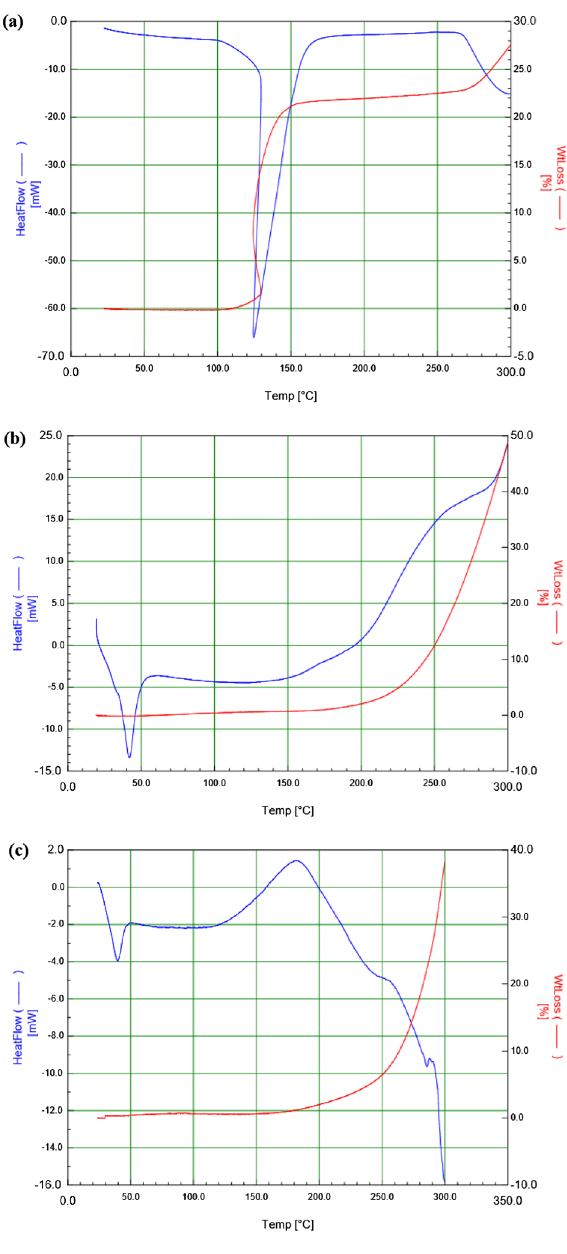
Figure 11. TG and DTG Curves of PEG, Co(II) and